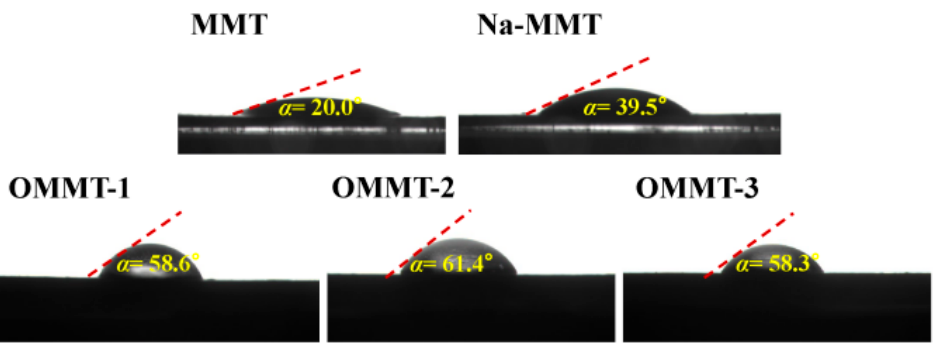
Figure 6. Photographs and corresponding contact angles of the montmorillonite (MMT), Na-MMT, OMMT-1, OMMT-2, and OMMT-3 samples.